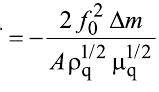
Figure 4: Normalized reflection spectra upon compression at the indi- cated surface pressure (left) and absorption spectrum of a 2.5 × 10 − 5 M solution of 1 in CHCl 3